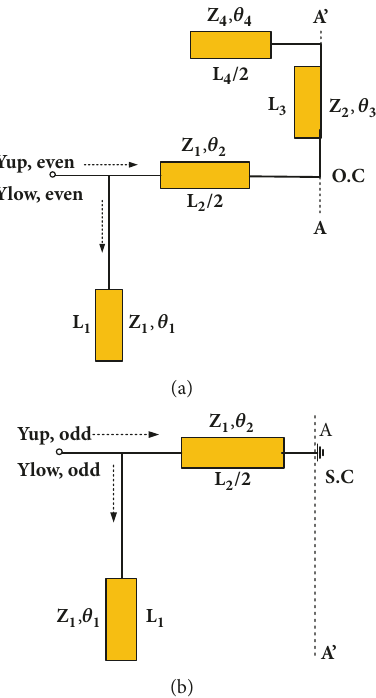
Figure 3: Equivalent circuit of different modes: (a) even mode; (b) odd mode.